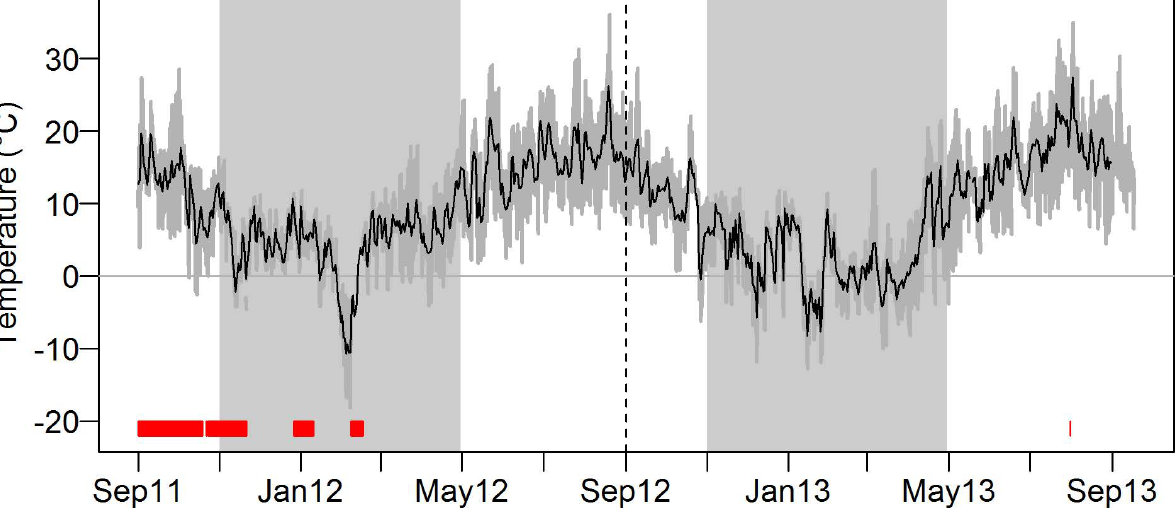
Figure 2. Air temperatures at 2 m height over the investigation period. Half-hourly averages (grey bars) are shown together with the daily mean (black line). The main growing seasons (May to October) are indicated by a grey background. The red bars at the bottom of the figure indicate times where, due to technical failure of the weather station at the study site, temperature data were obtained from other sources (see section ‘Environmental variables’ in the